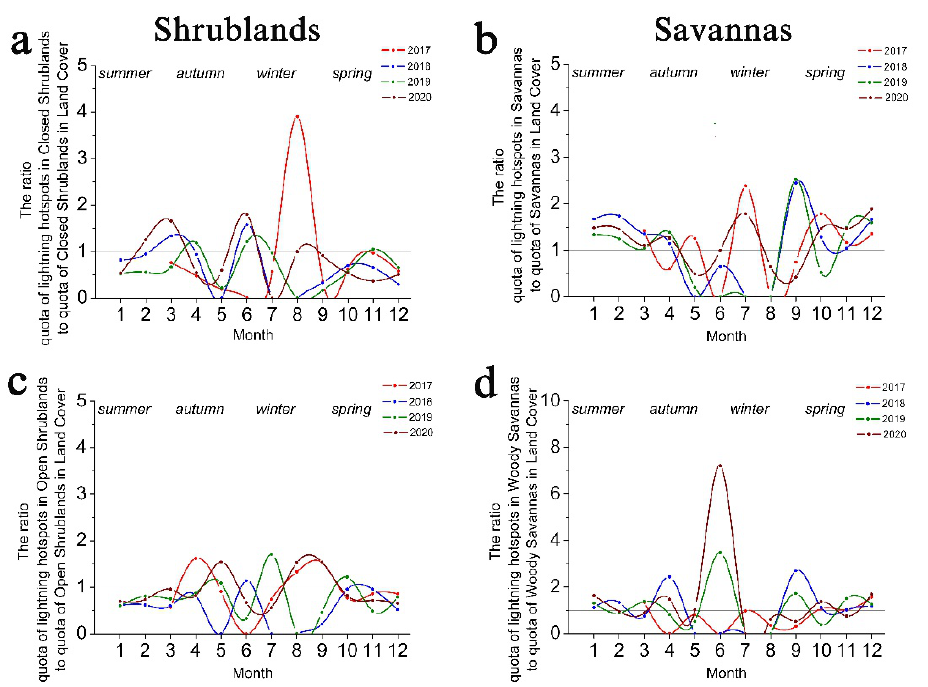
Figure 8. The monthly distributions of ratios of lightning attraction of open ( c ) and closed ( a ) shrublands, and of grasslands ( b ) and woody savannas ( d ), are presented.